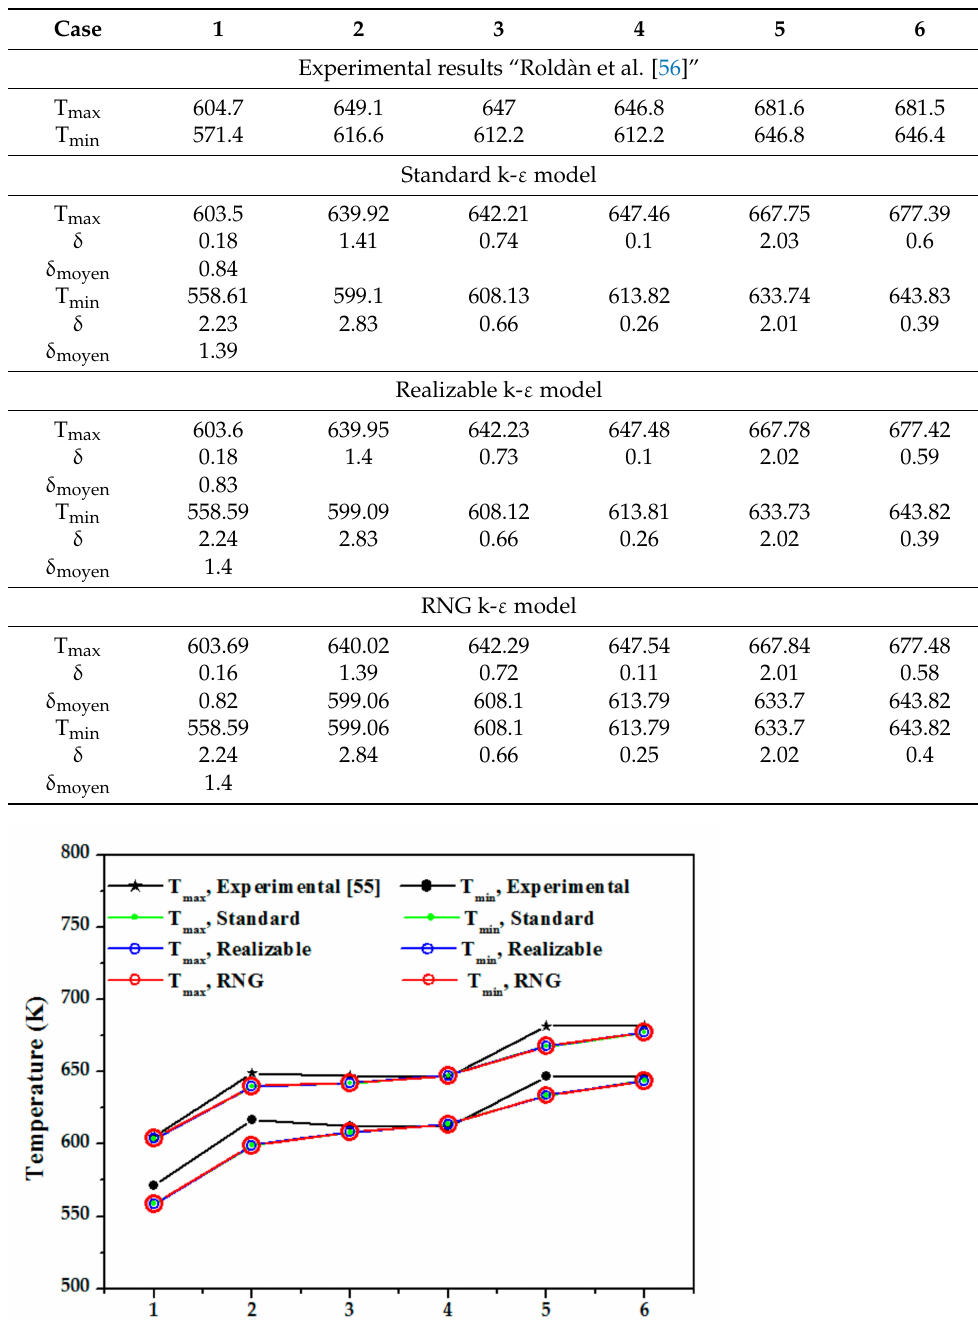
Table 3. Temperature variations between experimental and computational results in detail, with the relative error.